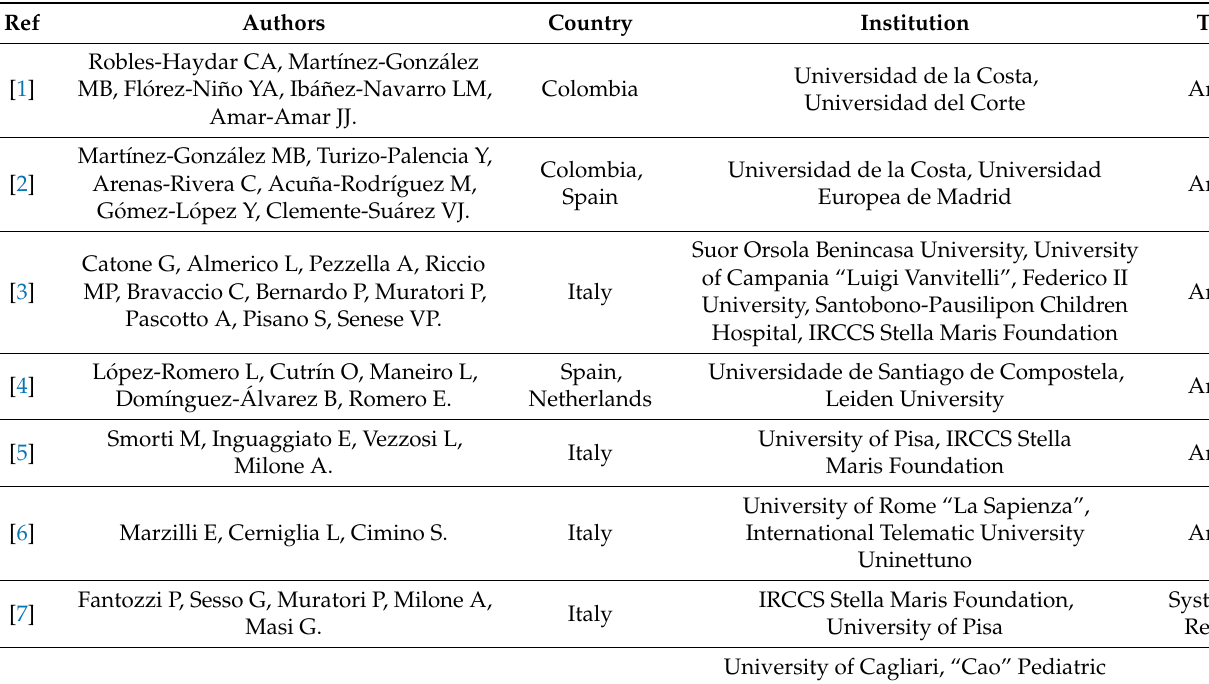
Table A1. Summary of the included